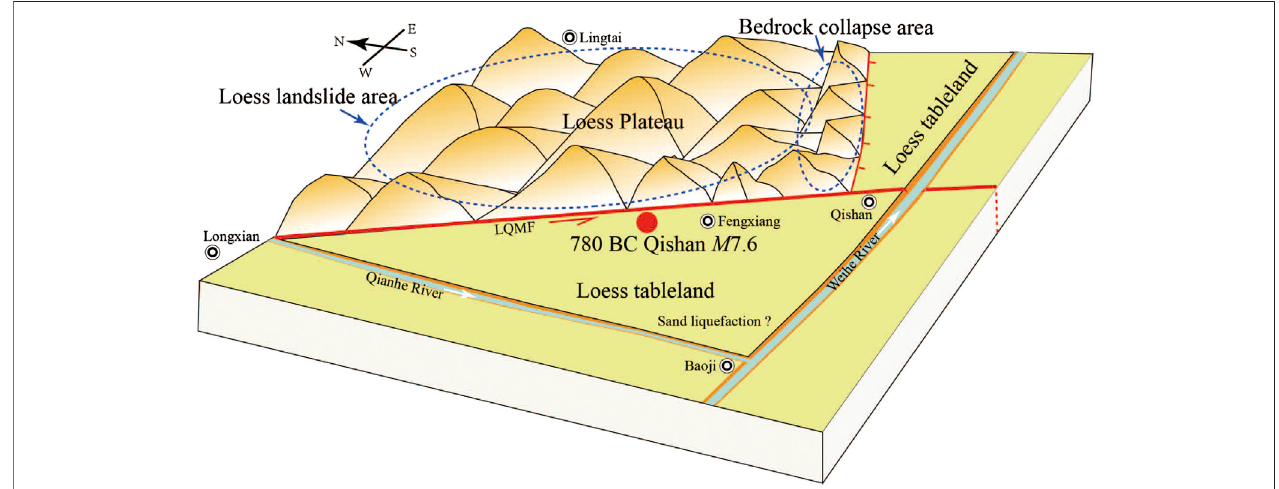
FIGURE 11 | Relationship between the distribution pattern of landslides in the dense area in this study and the 780 BC Qishan earthquake.